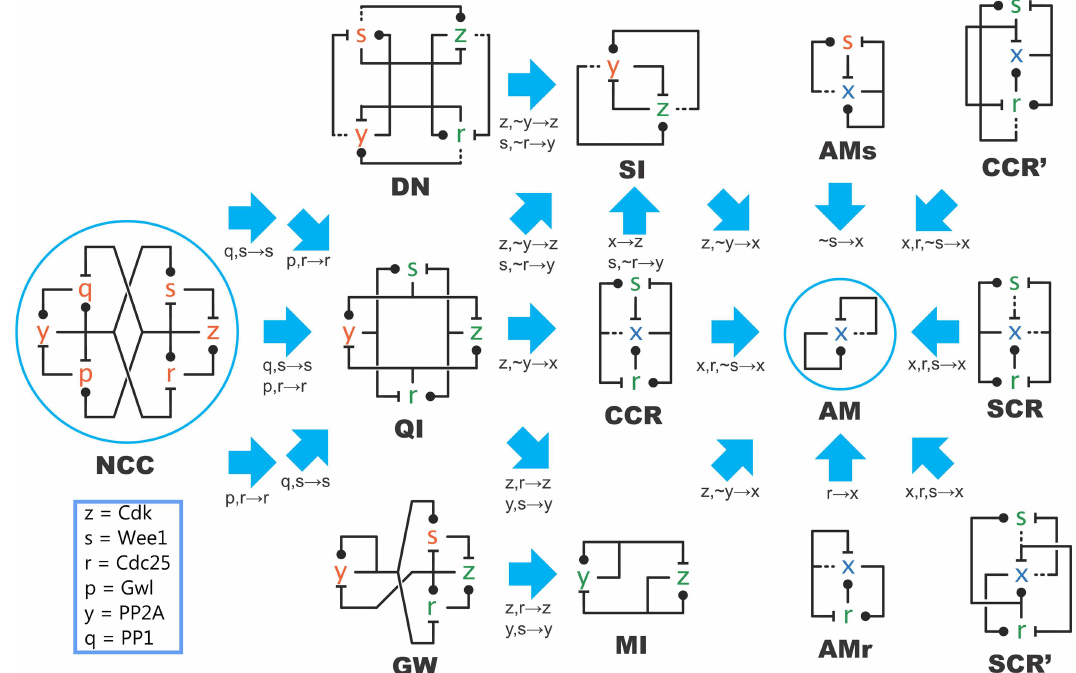
Fig 7. Network morphisms. Blue arrows are both homomorphisms and stoichiomorphisms, implyingkinetic emulation. The species mappingis indicatedunder each arrow; the reaction mappingis the associated homomorphic projectionthat simply respects the species mapping. A mappinglike ~y ! x means that the species y 0 ,y 1 ,y 2 are mapped respectivelyto x 2 , x 1 ,x 0 (basedon the notation of Fig 2). Molecularnames are indicatedfor the NCC network, which can be mappedback to some of the more basic ones (like GW and CCR), but not to all. Figure is adaptedfrom [44], where there is explanationon the abbreviated name